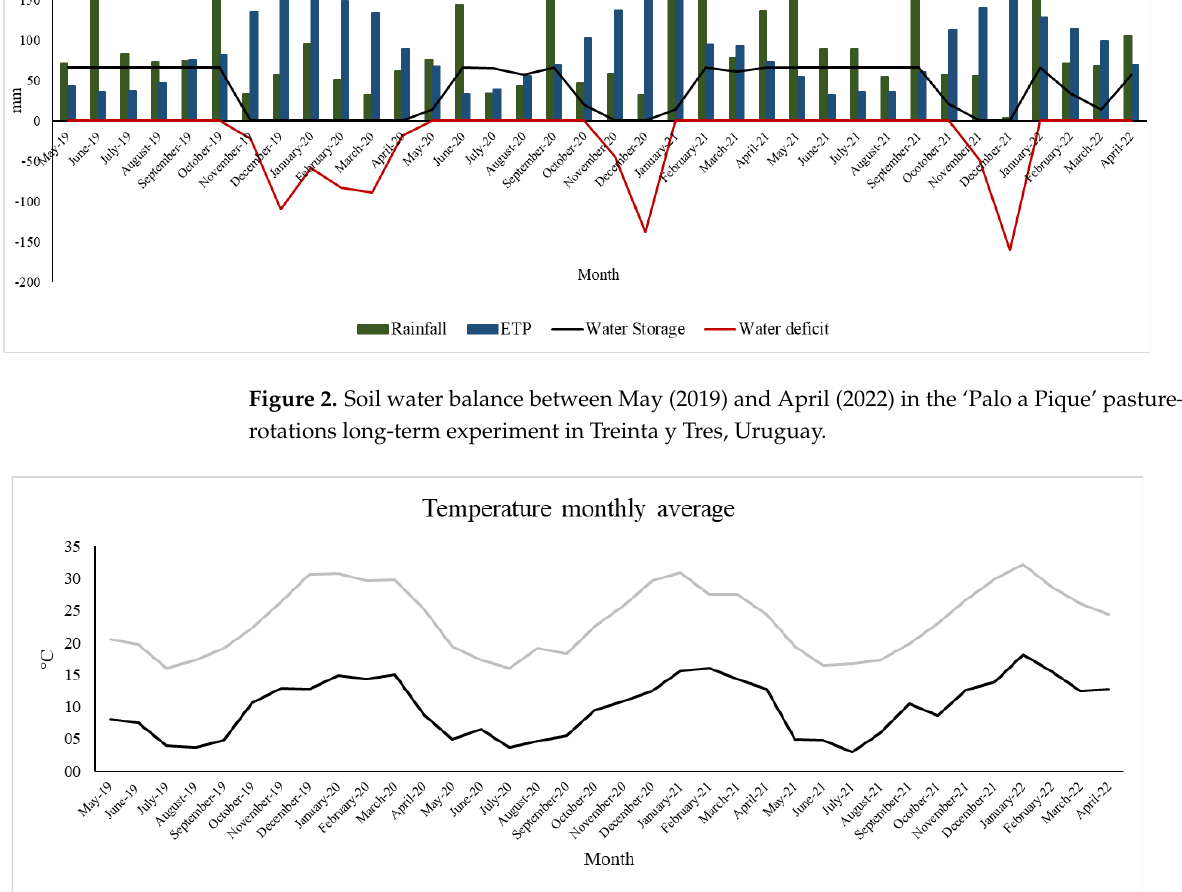
Table 4. Grain yield (t/ha) for crops in the ‘Palo a Pique’ pasture – crop rotations long-term experi-